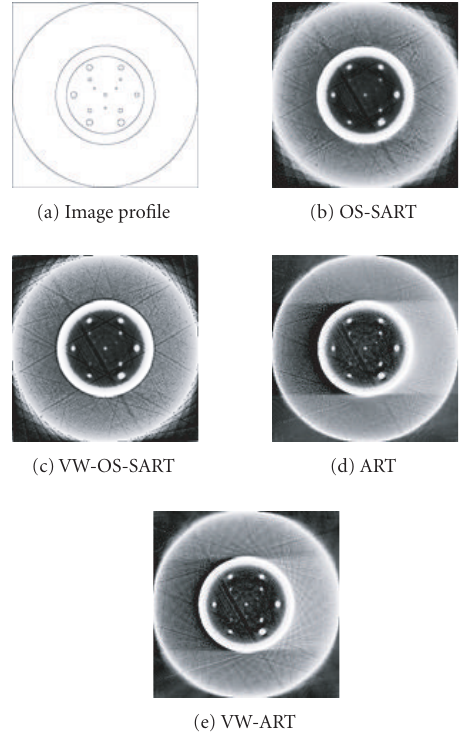
Figure 4: Reconstructed images by di ff erent algorithms using the practical data. The gray range is from 0 to